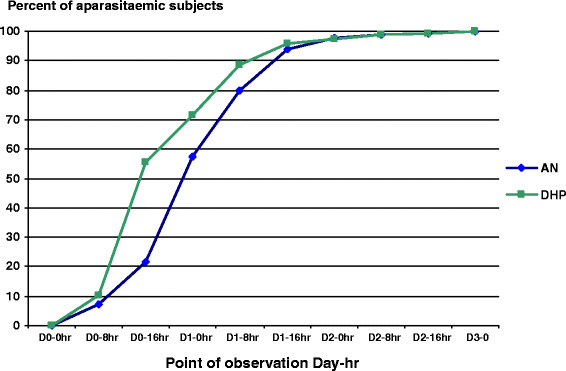
Proportions of aparasitaemic (asexual) malaria subject treated with artemisinin-naphthoquine (AN) versus dihydroartemisinin-piperaquine (DHP) groups were significantly difference by Day 0–16 hr (21.8% vs 55.6%, p < 0.0001), Day 1–0 hr (57.5% vs 71.3%, p = 0.01), and Day 1–8 hr (79.8% vs 88.5%, p = 0.03).